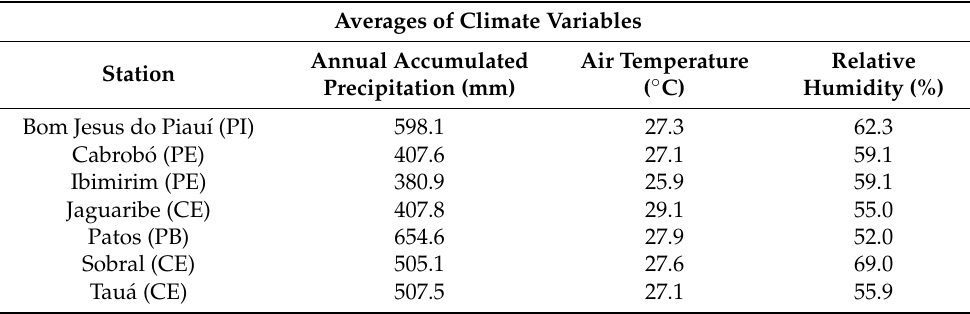
Table 2. Averages of climate variables of the seven municipalities according to Table 1. Averages of Climate